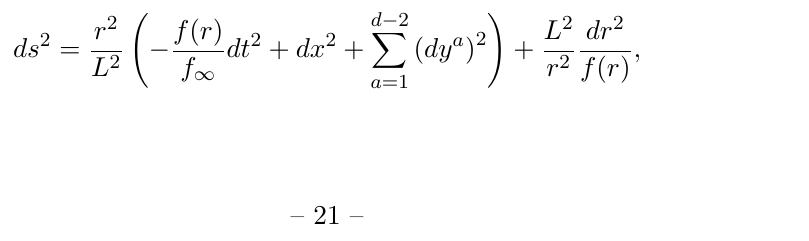
JHEP09(2022)037